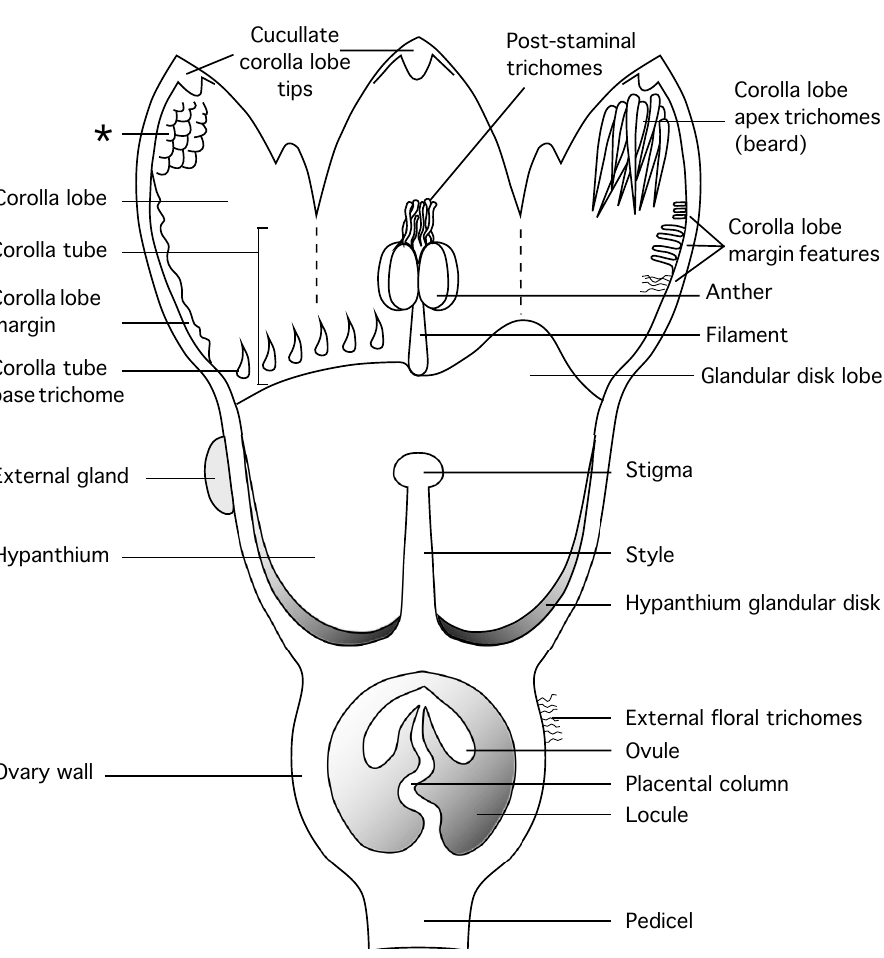
Figure 1. Diagramatic longitudinal section through a generalised Thesium flower. The figure was com- posited from numerous species, hence not all features occur in one species. Nearly all characters shown are variable within the genus. The asterisk (*) indicates the unique fleshy tissue seen lining the corolla lobes in T. nautimontanum